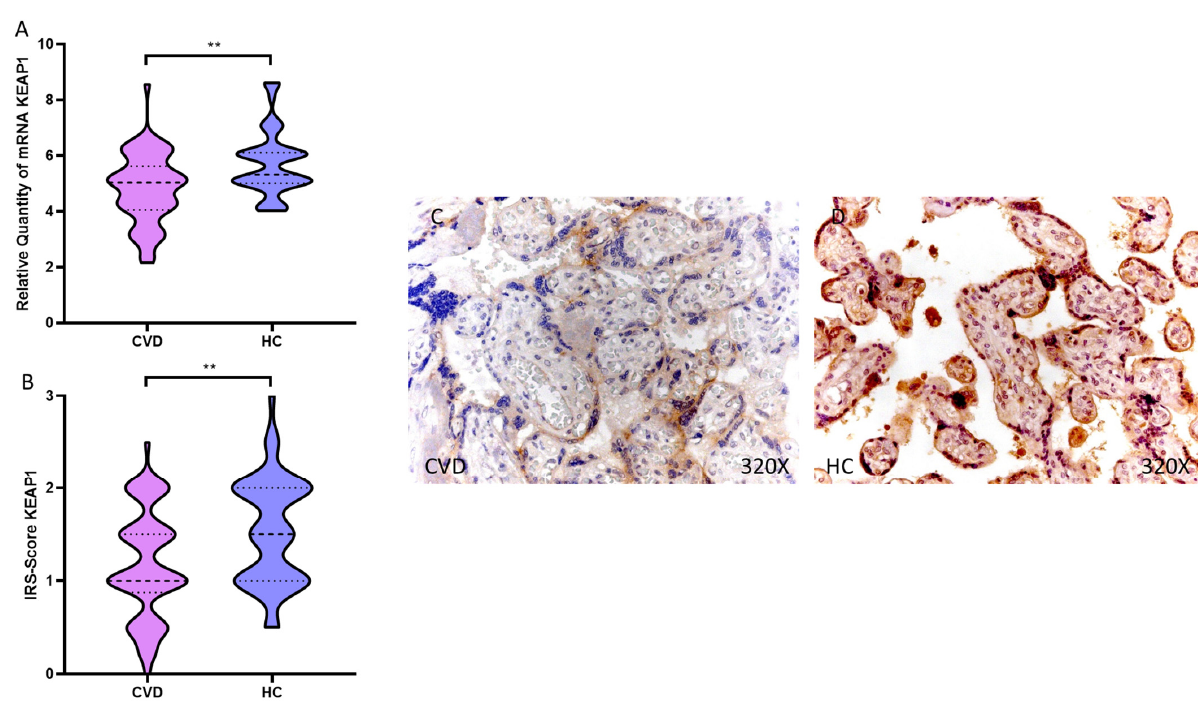
Figure 2. ( A ). KEAP1 mRNA expression in the CVD patients (chronic venous disease) and HC group (Healthy controls). ( B ). IRS ‐ Scores for KEAP1 in the placenta villi of the CVD group and the HV group. ( C , D ). Images showing the immunostaining for KEAP1 in the placenta villi of the CVD group and the HV group. p < 0.01 (**).